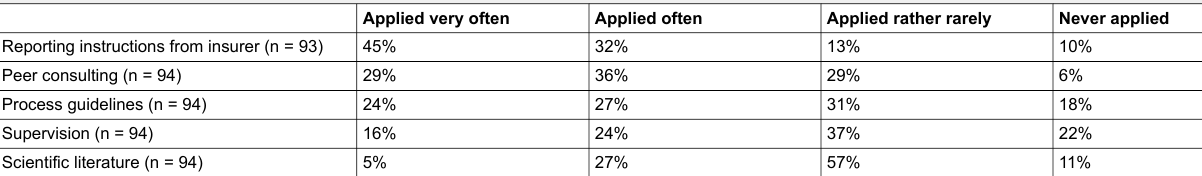
Table 4: Activities for quality control used by psychiatric